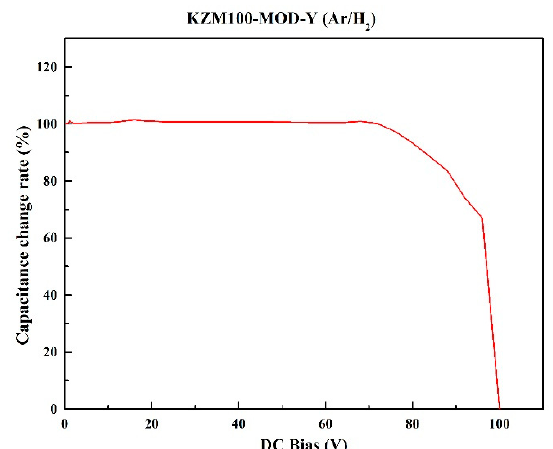
Figure 9. Capacitance change with DC bias for KZM100-MOD-Y.